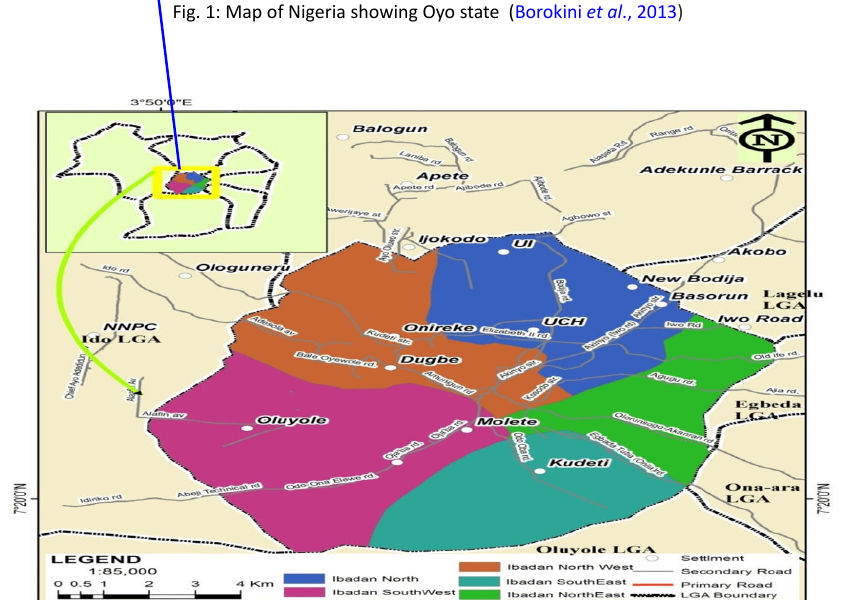
Fig. 1: M ap of Nigeria showing Oyo state Fig. 1 : M ap of Nigeria showing Oyo state (Borokini et al ., 2013 ) (Borokini et al ., 2013)